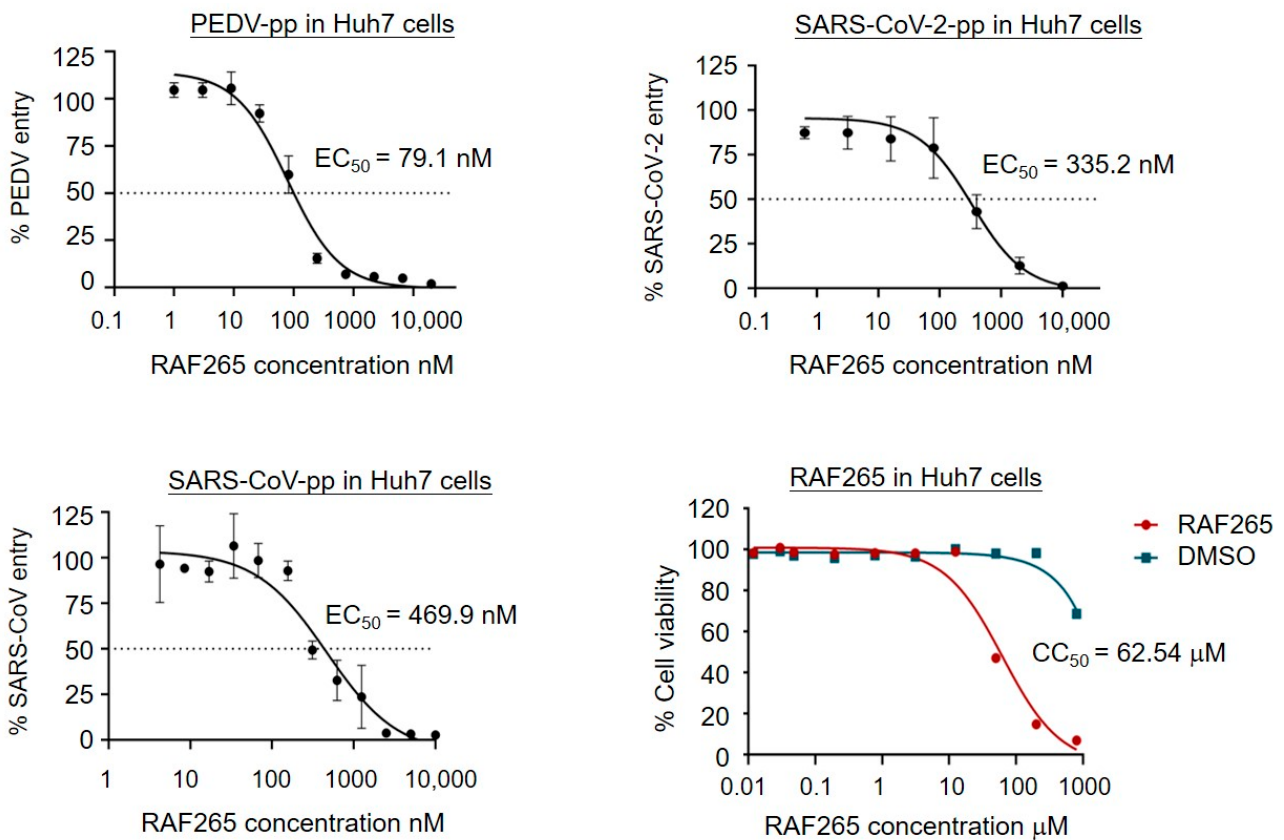
Figure 3. RAF265 targeted the entry of PEDV, SARS-CoV, and SARS-CoV-2. Huh7 cells were transduced with PEDV-pp, SARS-CoV-pp, or SARS-CoV-2-pp in the presence of serially diluted RAF265 or DMSO. Forty-eight hours after transduction, the cells were lysed and incubated with luciferase assay substrate. The cytotoxicity of RAF265 was evaluated by MTT assay. Data were analyzed with GraphPad Prism 7 (GraphPad Software, San Diego, CA, USA). For entry assay, the infectivity data were first inverted to antivirus activity. Each data set was normalized by the background control (no virus) to define the real value for 100%. The values shown in the graphs are presented as mean ± SEM.